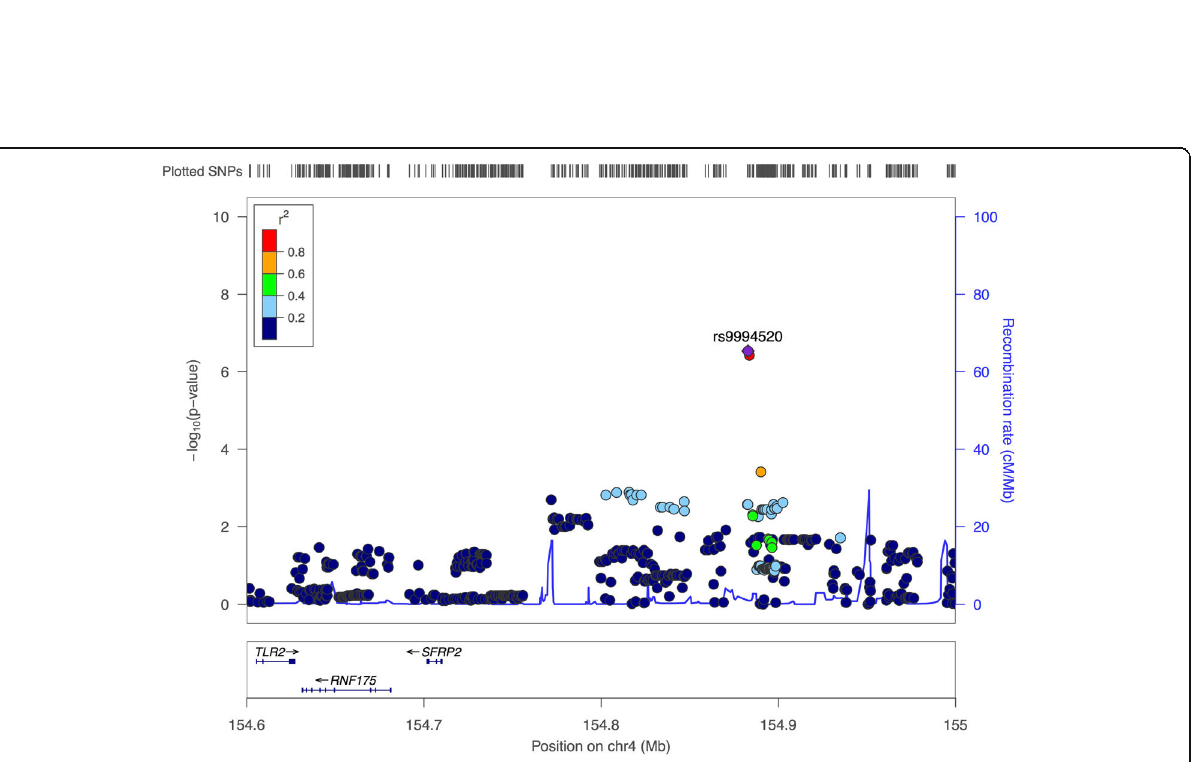
Fig. 3 pQTL association signals at baseline in the region of surrounding rs4360730 and rs74234276 and BUD12 , APOA4 , APOA5 , and ZNF259 ( ZPR1 ) genes cluster. Association plot produced using LocusZoom software for SNPs associated to ANGPTL3 protein level at baseline. SNPs ’ p values are plotted after − log10 transformation with scale on the y -axis and colors reflect pairwise linkage disequilibrium with the most associated SNP in the region (purple dot) based on the 1000 genomes EUR data